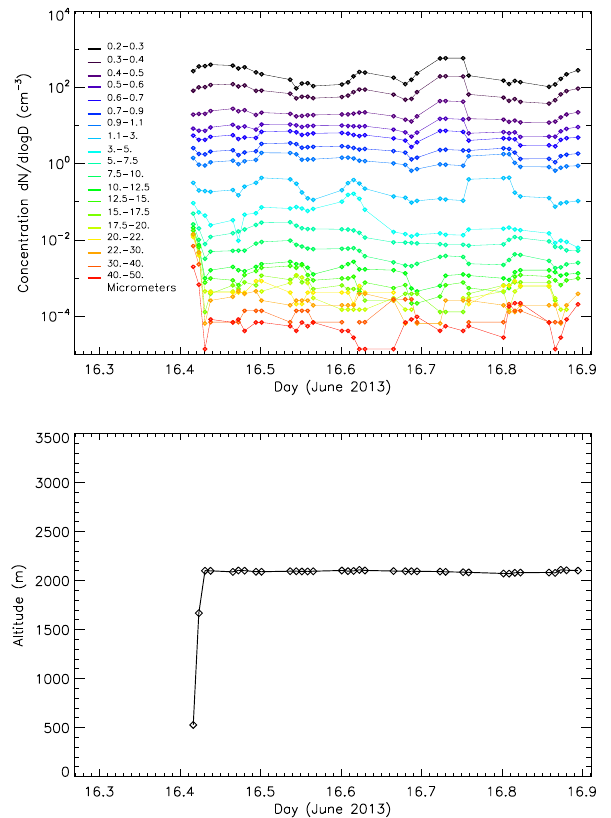
Figure 15. Particle size distribution measured with a LOAC dur- ing the ∼ 12h flight of BPCL balloon B74 drifting from Minorca towards Marseilles (see the trajectory in Fig. 4). The first and last 20min correspond to the ascending and descending phases of the quasi-Lagrangian flight that occurred at a constant altitude of 2091 ± 10m.